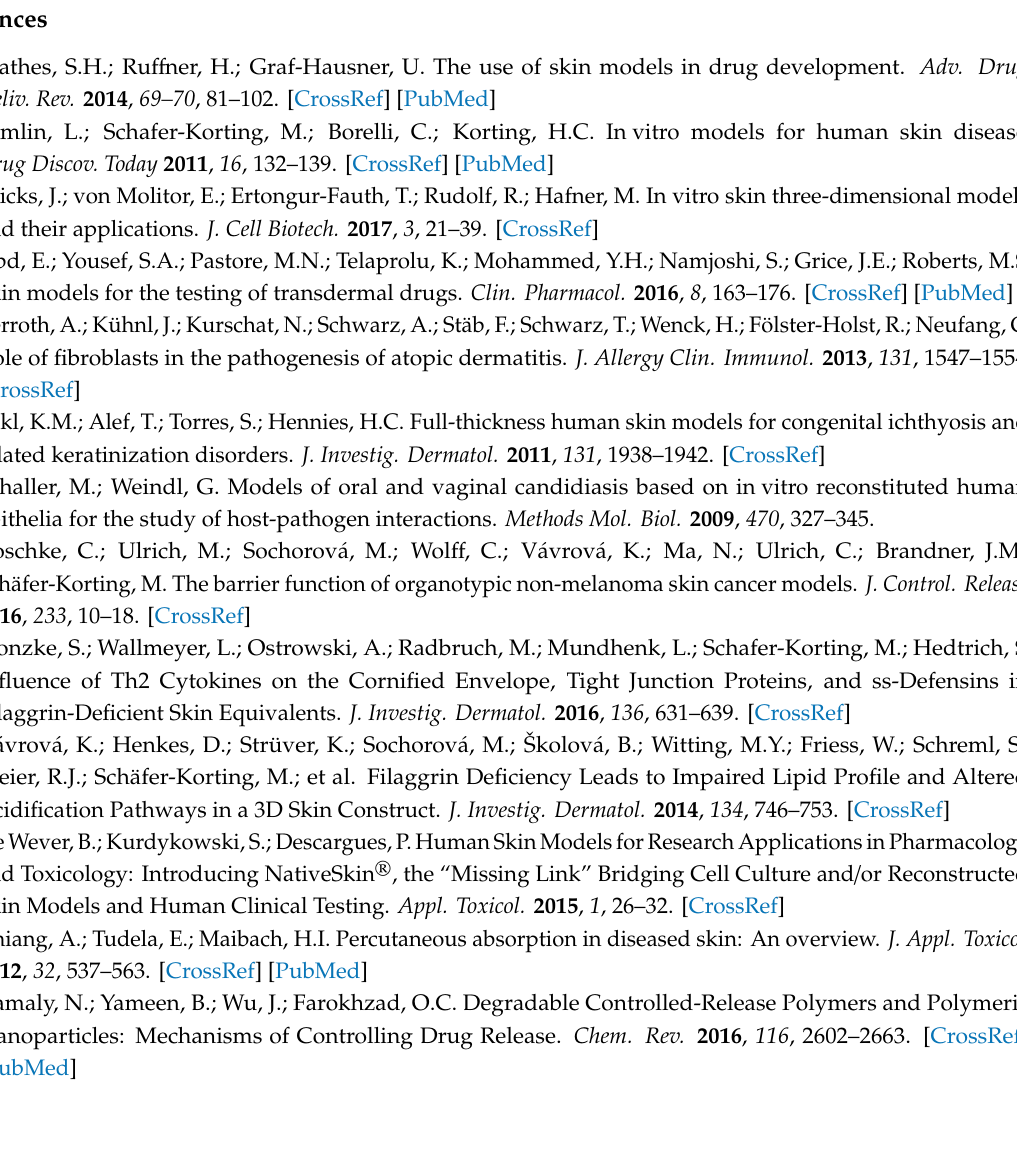
Figure S1: Histological assessment of ex vivo human skin treated with SP. Figure S2: Influence of SP treatment on epidermis cell proliferation in ex vivo human skin. Figure S3: Expression of pro-inflammatory markers IL 6, IL 8, TSLP and IL 1 α in ex vivo human skin. Figure S4: Relative expression profiles of pro-inflammatory mediators in ex vivo human skin after SP